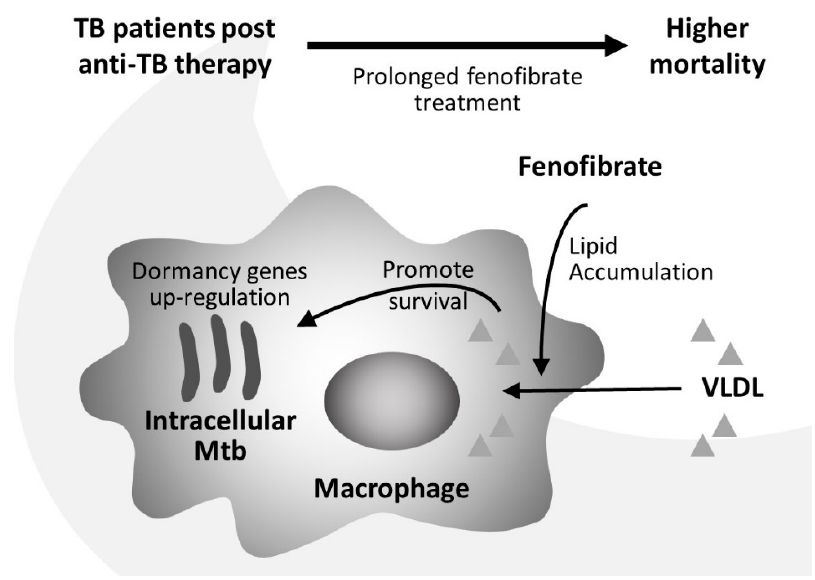
Figure 5. A schematic representation of the proposed mechanism for how fenofibrate, a lipid-lowering drug, can increase intracellular Mycobacterial tuberculosis ( Mtb ) viability. Fenofibrate and very low-density lipoprotein (VLDL) induced the formation of foamy macrophages. Next, fenofibrate and VLDL enhanced the survival and growth of Mtb in human macrophages. In parallel, fenofibrate and VLDL upregulated the expression of the icl1 , tgs1 , and devR genes, which could bear relevance to the lipid metabolism and survival of Mtb in non-replicating persistent / latent infections. Together, these data indicated that hyperlipidemia with fibrate may increase lipid accumulation in human macrophages as nutrient-rich reservoirs for Mtb , which may result in subclinical TB disease activity. Eventually, long-term fenofibrate treatment probably presented higher risk of mortality in patients with post-active TB infection.